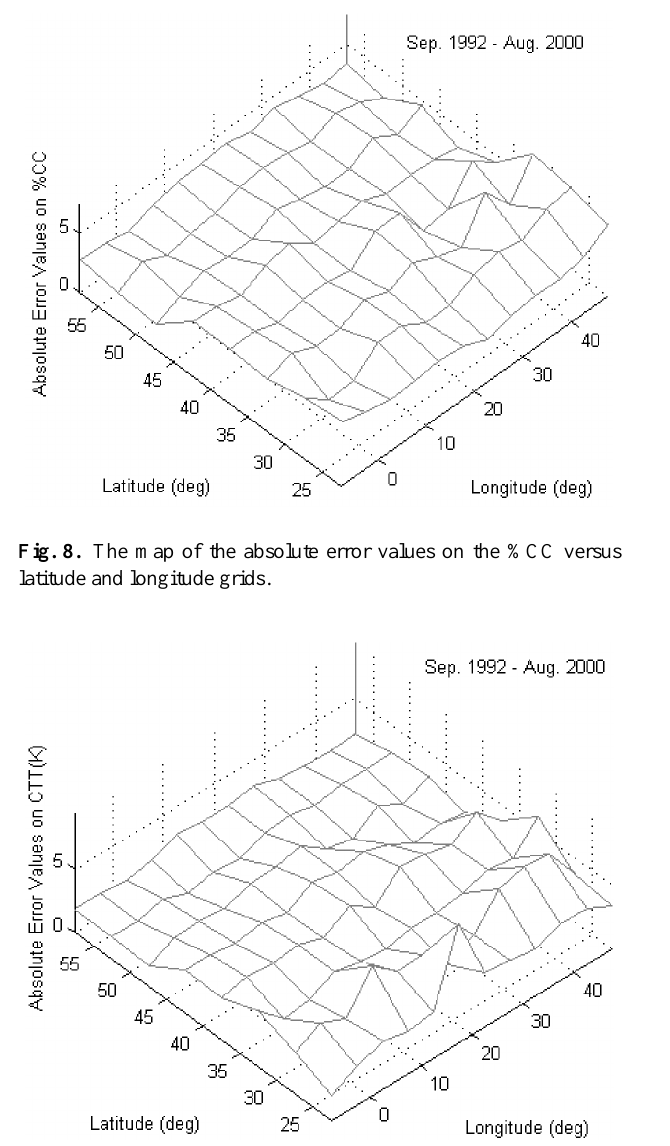
Fig. 9. The map of the absolute error values on the CTT versus latitude and longitude grids.